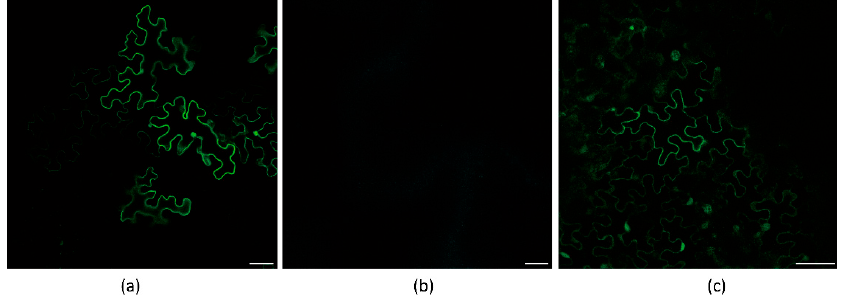
Figure 5. Frameshift expression of WYMV P3N-PIPO mutants in N. benthamiana leaf cells under confocal microscopy. ( a ) PVX-WYMV P3N-PIPO-WT-GFP expressed in the epidermal cells treated eight days post-agroinfiltration; ( b ) PVX-P3N-PIPO-M1-GFP expressed in the epidermal cells treated eight days post-agroinfiltration; ( c ) PVX-P3NPIPO-M2-GFP expressed in the epidermal cells treated eight days post-agroinfiltration. Bars, 50 µ